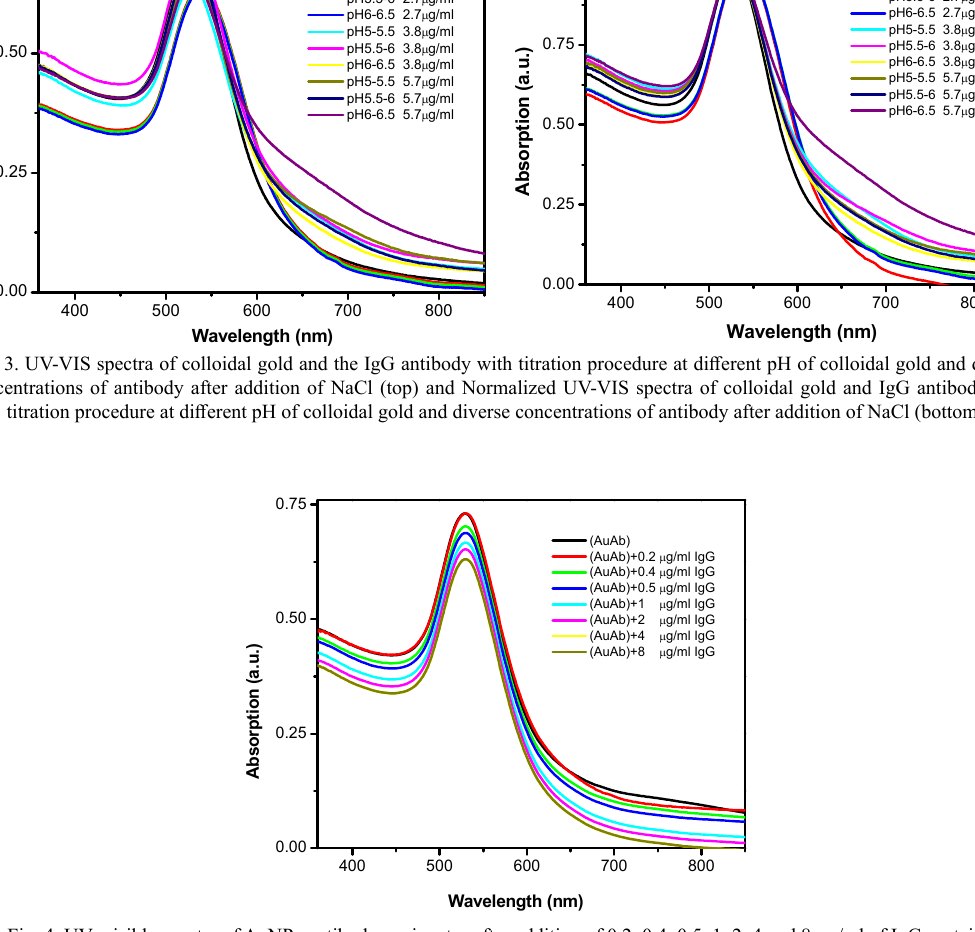
Fig. 4. UV- visible spectra of AuNPs-antibody conjugates after addition of 0.2, 0.4, 0.5, 1, 2, 4 and 8 µg/ml of IgG Fig. 4: UV- visible spectra of AuNPs-antibody conjugates after addition of 0.2, 0.4, 0.5, 1, 2, 4 Fig. 3: UV-VIS spectra of colloidal gold and the IgG antibody with titration procedure at and 8 µg/ml of IgG protein. different pH of colloidal gold and diverse concentrations of antibody after addition of NaCl (top) and Normalized UV-VIS spectra of colloidal gold and IgG antibody with titration procedure at different pH of colloidal gold and diverse concentrations of antibody after addition of NaCl (bottom).